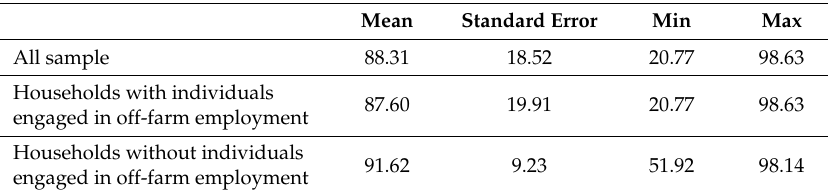
Table 3. Frequency Distribution of irrigation water